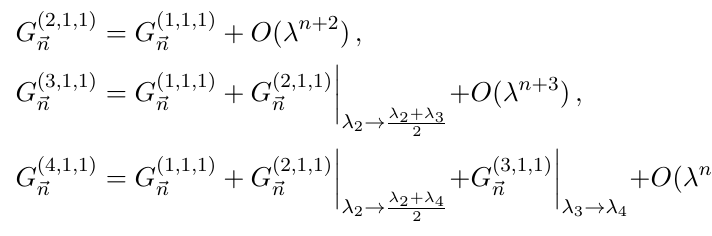
general pattern for the expansions in the A